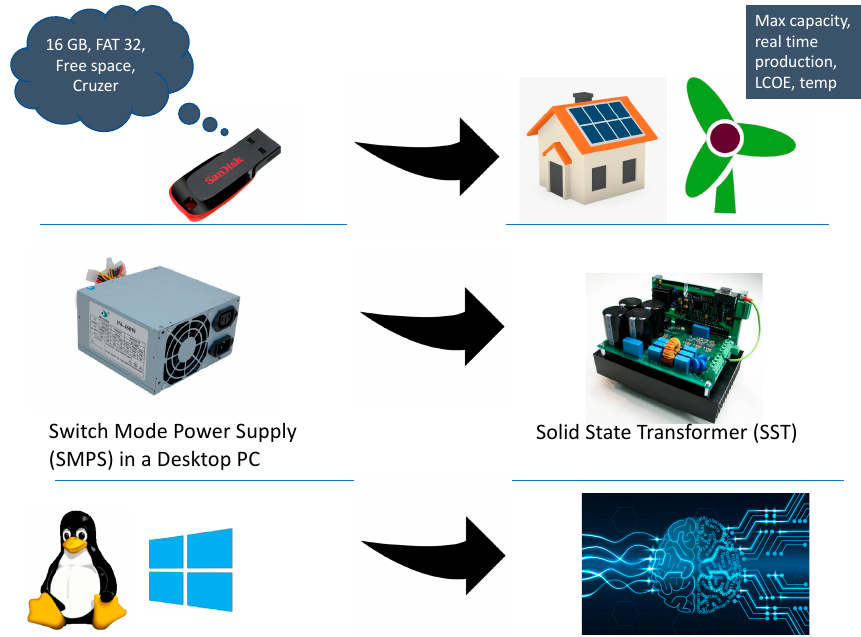
Figure 4. Feature comparison of internet devices and energy internet.